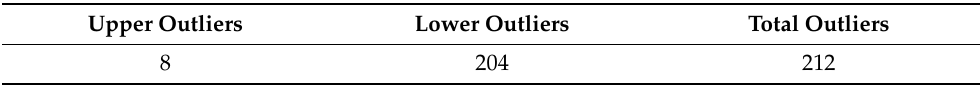
Figure 7. Real GreEn-ER global power consumption with inserted outliers. Table 5. Number of outliers on real data found manually.